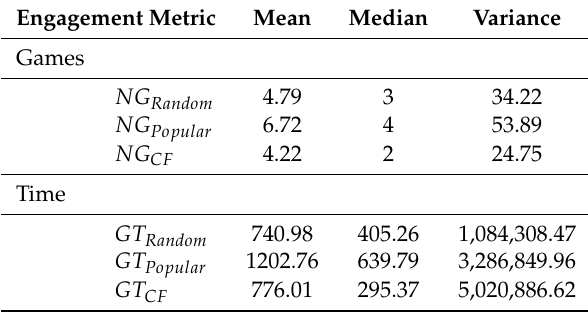
Table 3. Engagement metrics for game apps by recommender for the period from 15 October 2018 to 1 December